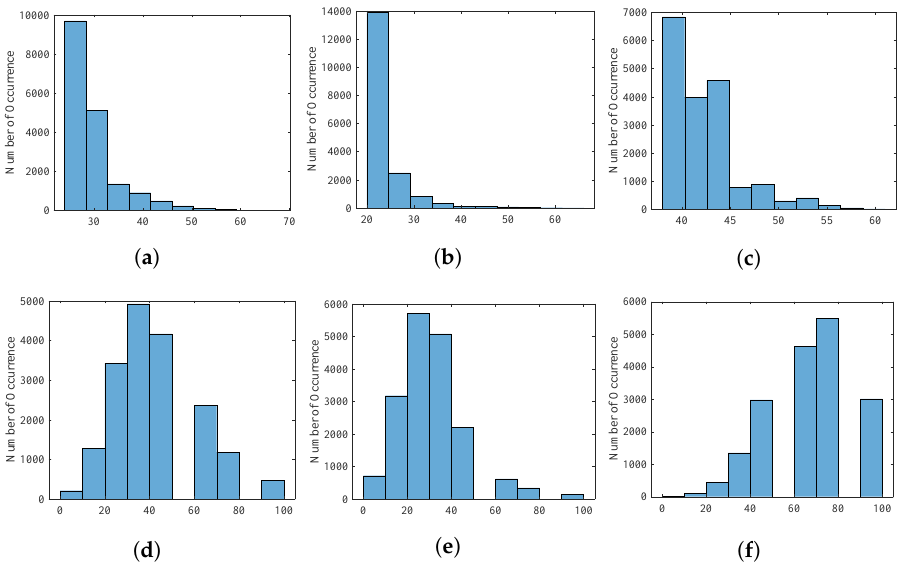
Figure 11. Validation data characteristics of the Nadam model (three layers) with 30% dropout: ( a ) uniqueness of nonce 1; ( b ) uniqueness of nonce 2; ( c ) uniqueness of port; ( d ) randomness of nonce 1; ( e ) randomness of nonce 2; ( f ) randomness of port.